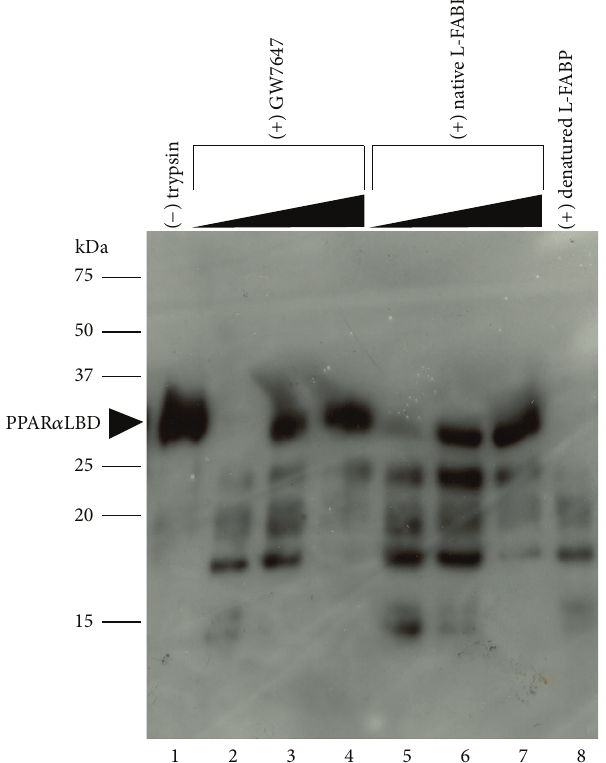
Figure 6: Proteolytic protection of PPAR 𝛼 LBD through interactions with L-FABP. A fixed concentration of PPAR 𝛼 LBD (30 𝜇 M) was digested with trypsin in the presence of increasing concentrations of native LFABP (0, 50, 100 𝜇 M). Control protein digests were performed in the presence of increasing concentrations of the PPAR 𝛼 selective drug GW7647 (0, 1, 5 𝜇 M) or heat denatured L-FABP. The gel was probed by western blotting with a PPAR 𝛼 LBD antibody. The position of the intact PPAR 𝛼 LBD protein band is